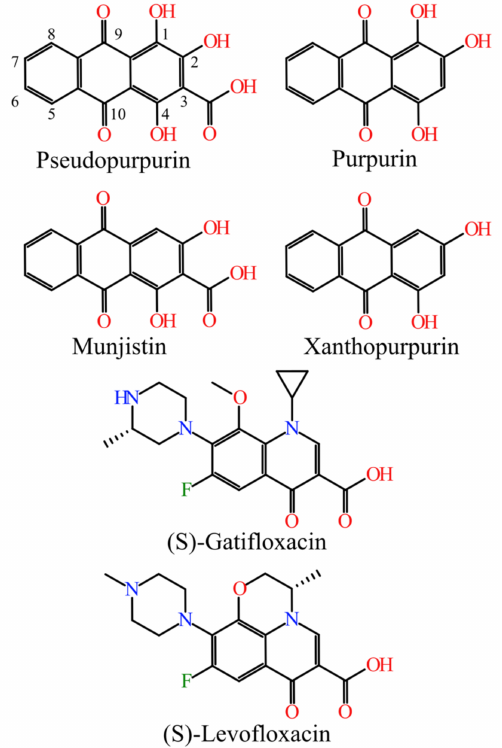
Figure 1. Chemical structures of the four naturally-occurring hydroxyanthraquinones and the two synthetic